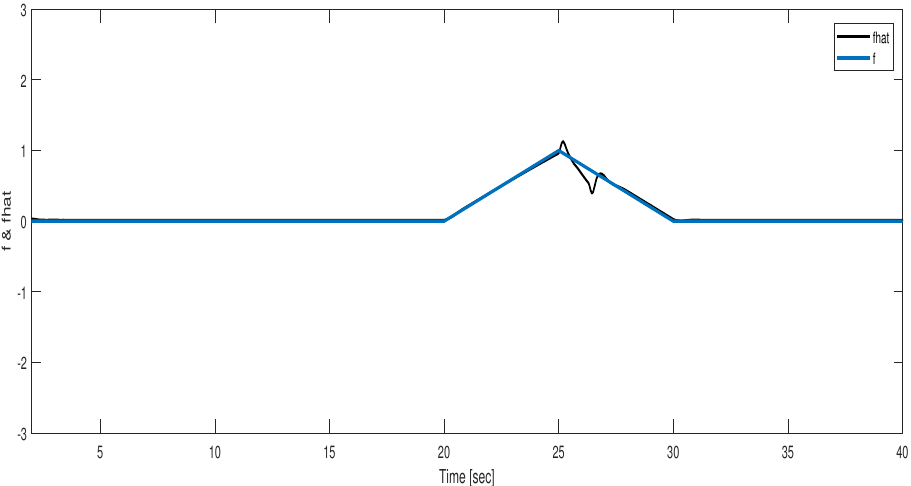
Figure 3. Illustration of robust sensor fault reconstruction (pitch angle sensor